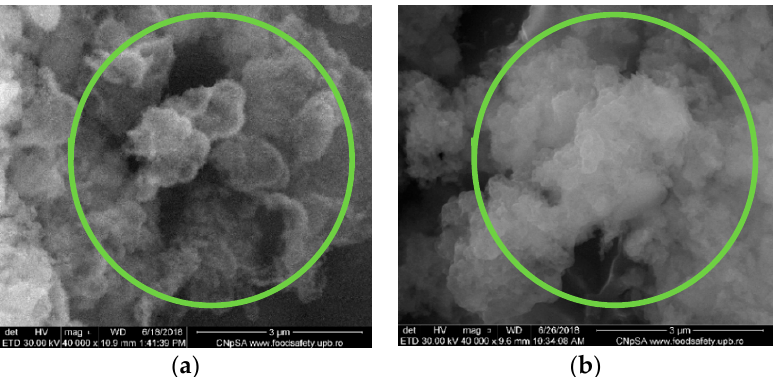
Figure 8. SEM images of the Coll/CaPs thin films with 1 wt% Zn(II)deposited by ( a ) Spin coating; ( b ) MAPLE after 14 days of immersion in SBF. The presence of Zn along with Na, K and Mg, characteristic to the artificial mineralization process, is confirmed by EDAX spectra in Figure 9.